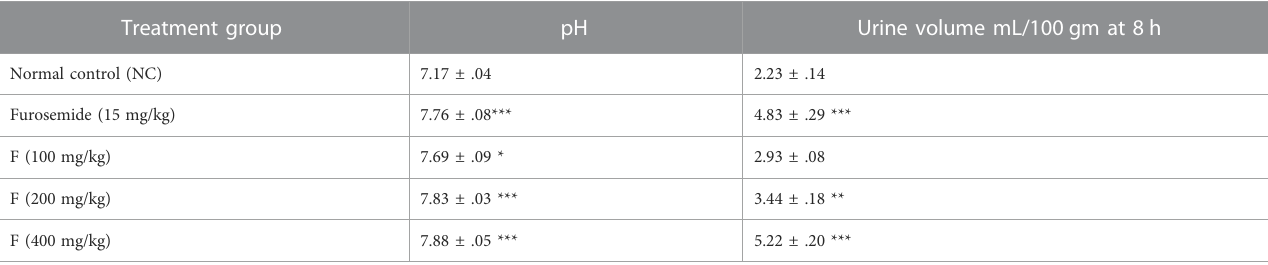
TABLE 6 Effect of different doses of fenchone on pH and urinary volume. Treatment